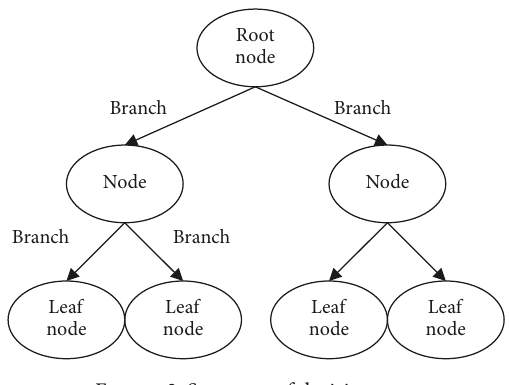
Figure 2: Structure of decision tree. Table 1: Classifications of solar X-ray